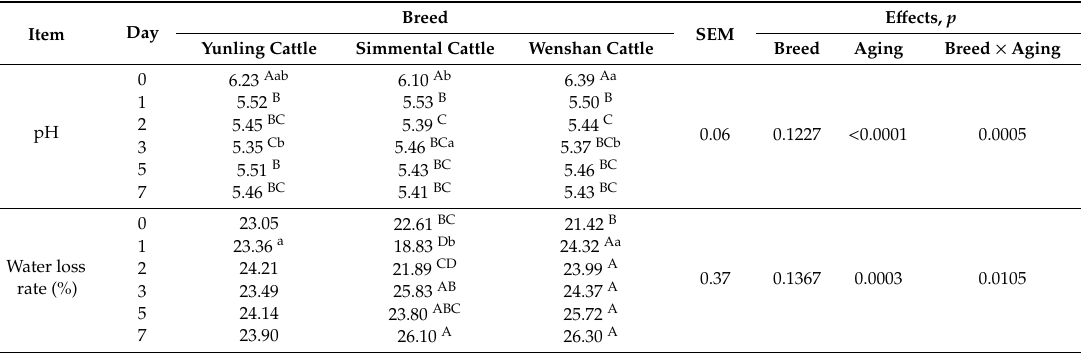
Table 3. The pH and water loss rate a ff ected by breed and